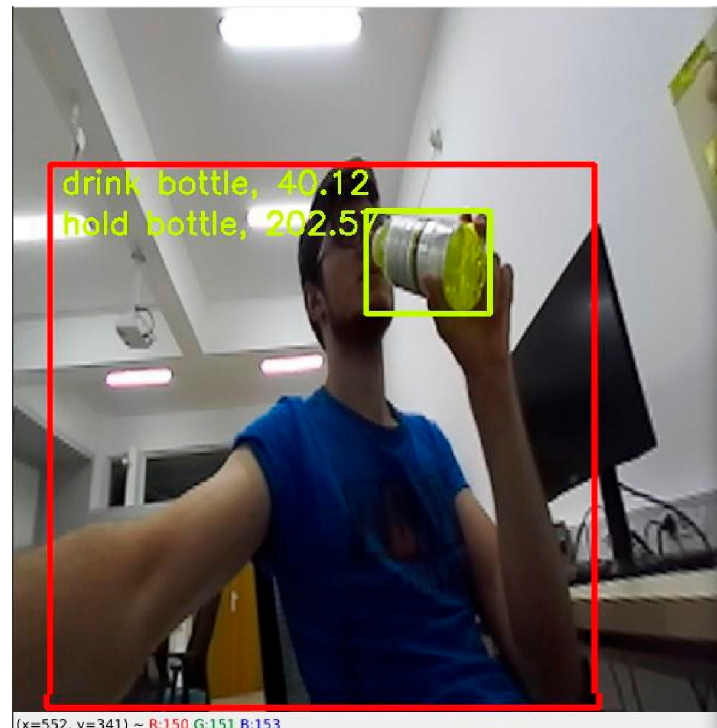
Figure 19. Activity detection result.